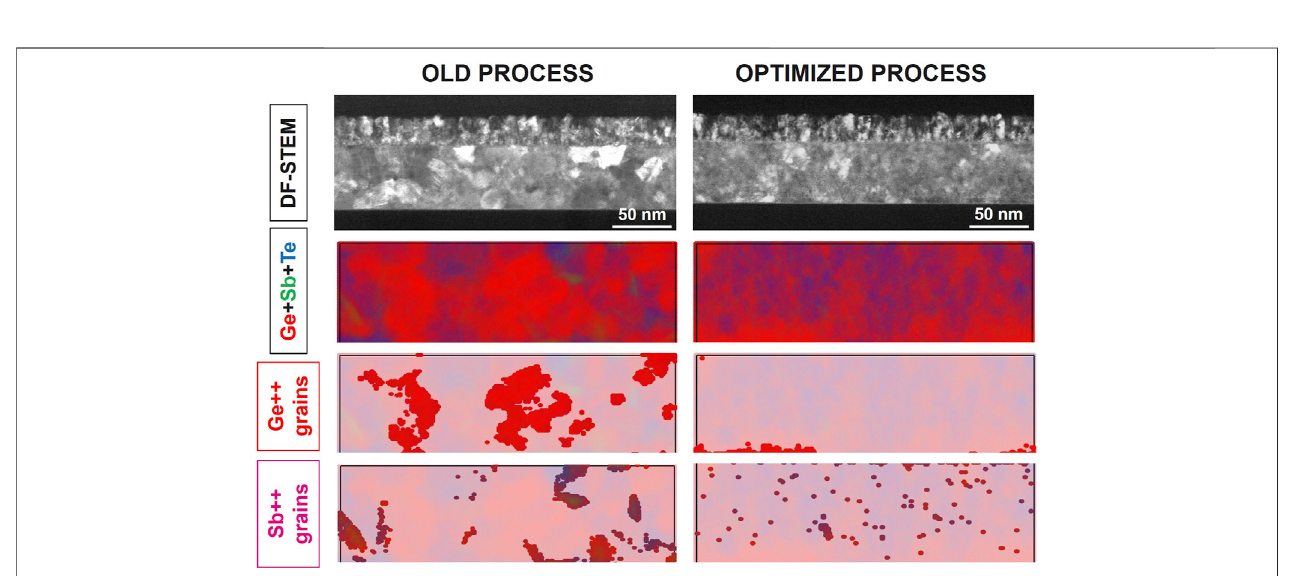
FIGURE 8 | Morpho-chemical results of “ old process ” vs. “ optimized process ” : in the fi rst line, DF-STEM images are reported, highlighting different crystalline contrasts; in the second line, superposition of main elements ’ signal maps (Ge + Sb + Te signals, reported in red, green, and blue, respectively) are reported; in the third and fourth lines, corresponding signal maps are reported, where the highest content of Ge and Sb-rich outliers are highlighted, respectively.